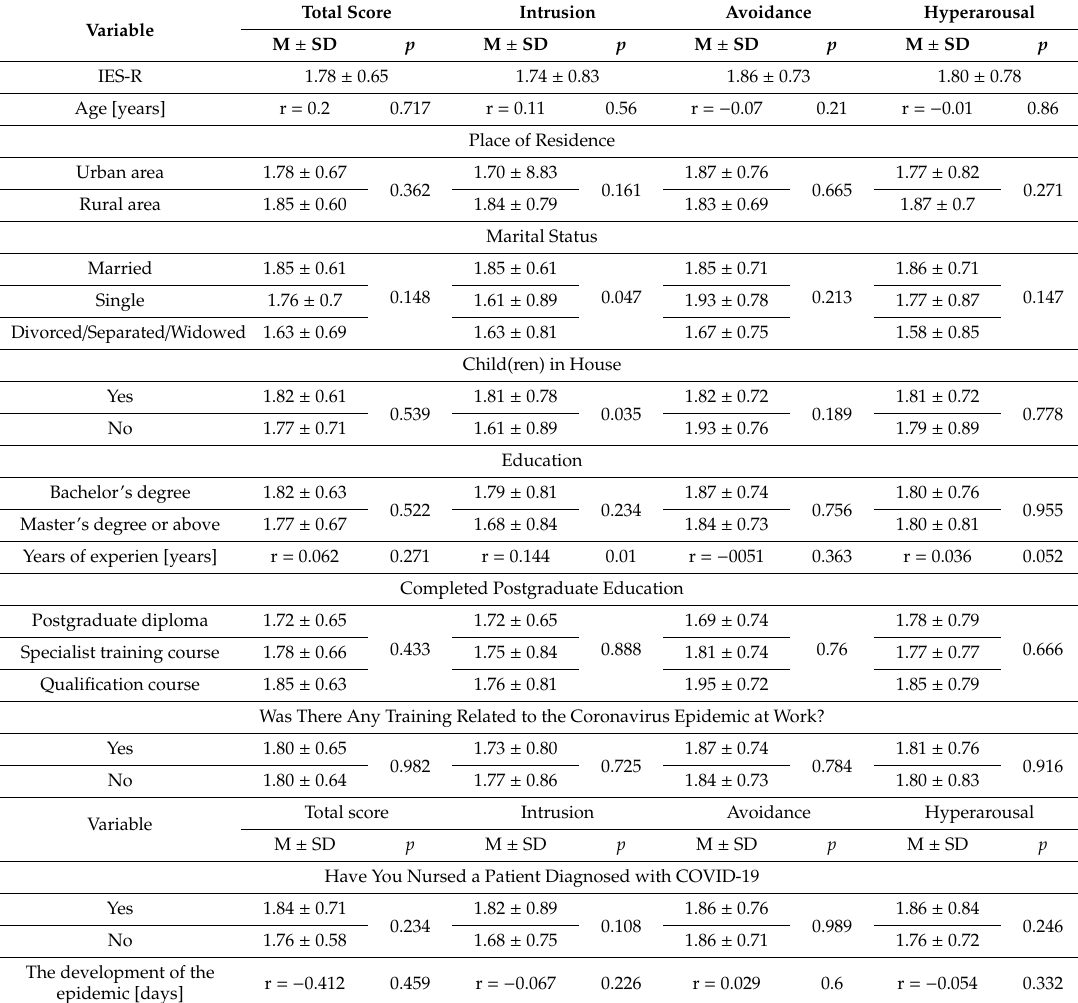
Table 2. Thelevelofexperiencedtraumaticstressanditscomponents;